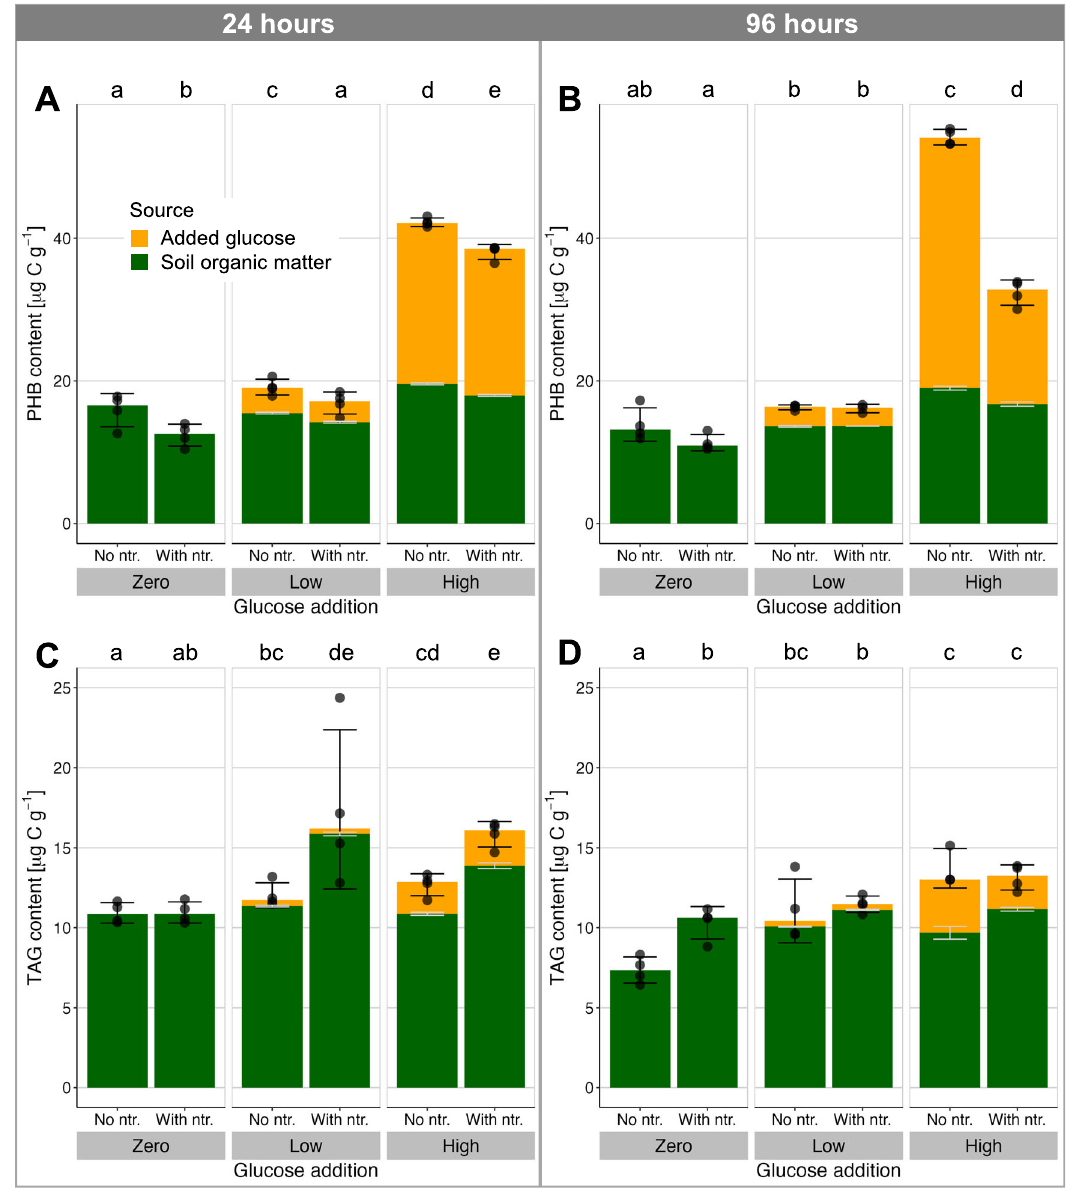
Fig. 2 | Response of soil microbial storage to organic carbon and nutrient supply. Storage compounds PHB A , B and TAGs C , D in soil 24h A , C , and 96h B , D afteradditionofareadilydegradable, 13 C-labelledcarbonsource(glucoseat0, 90 and 400 µ gCg − 1 soil) with or without mineral nutrient supply (ntr.; N, P, K, S). The source of the stored C is shown in contrasting colours as determined by iso- topiccomposition,withlightgreyerrorbarsre fl ectingmean±standarddeviationof the relative composition. Black error bars show mean±standard deviation of the